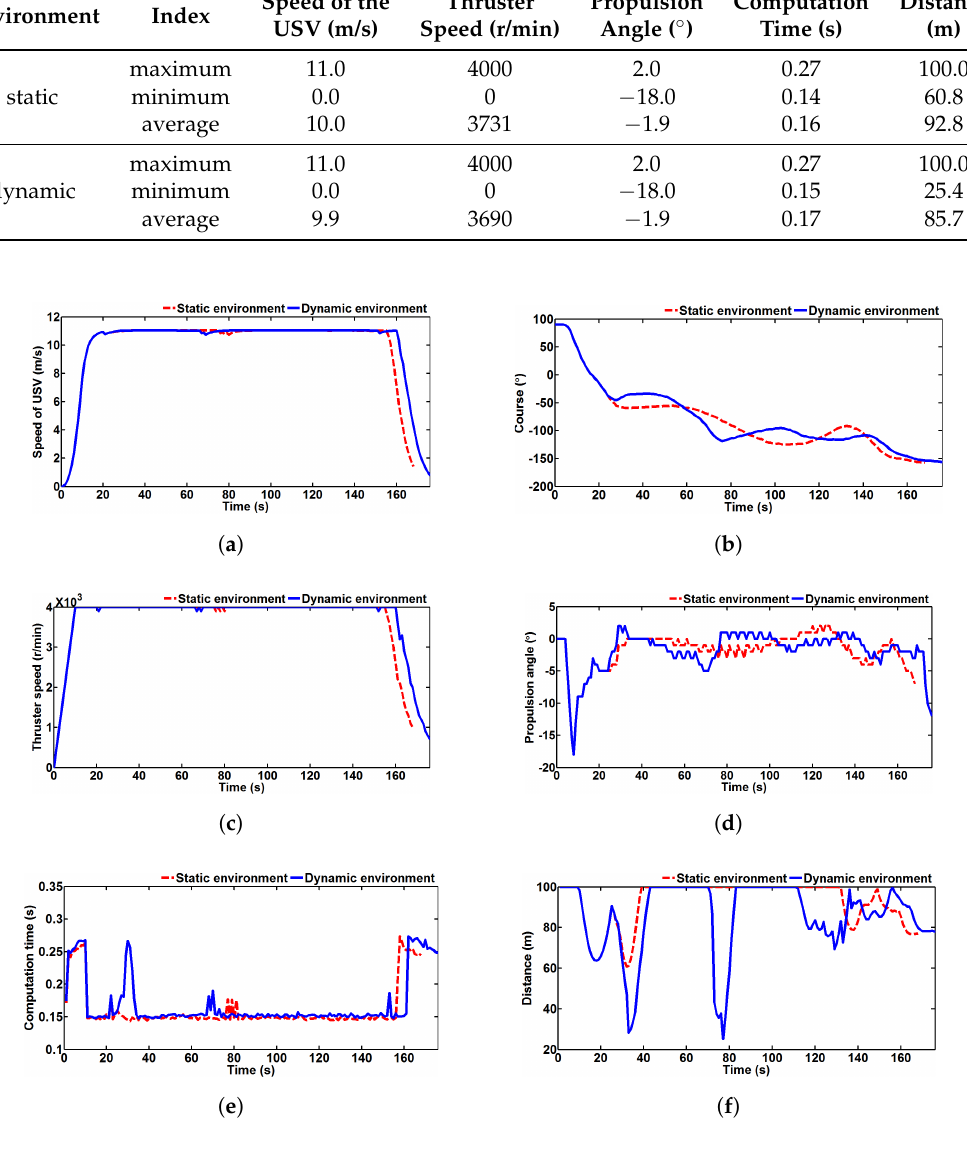
Figure 22. Evaluation results in the real environment. ( a ) Speed of the unmanned surface vehicle (USV); ( b ) Course of the USV; ( c ) Thruster speed; ( d ) Command propulsion angle; ( e ) Computation time; ( f ) Distance between the USV and the collision